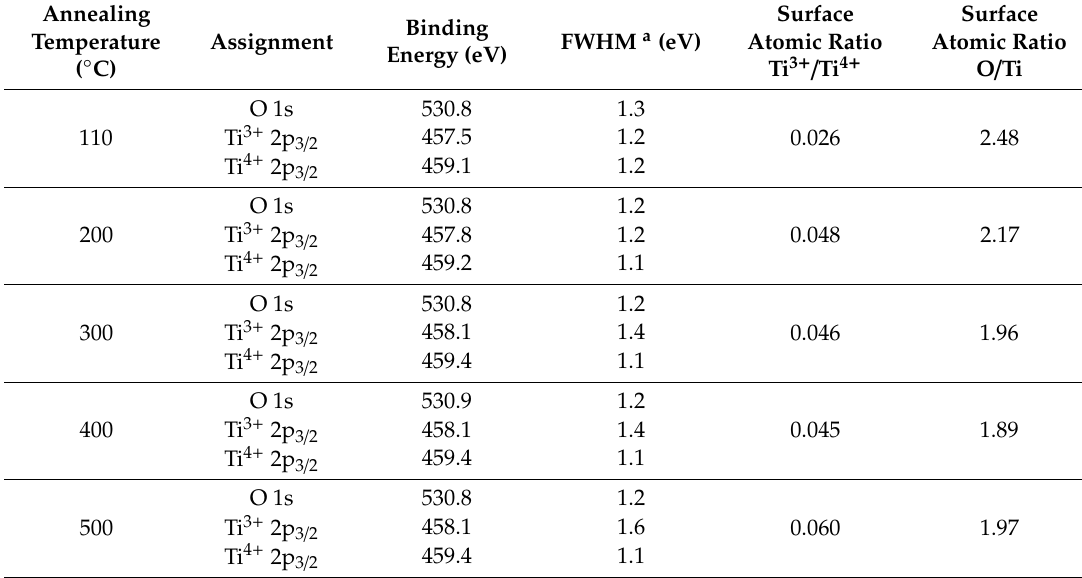
Table 1. XPS parameters of Ti 2p 3 / 2 and O 1s derived from spectral fitting. Reproduced from [43].